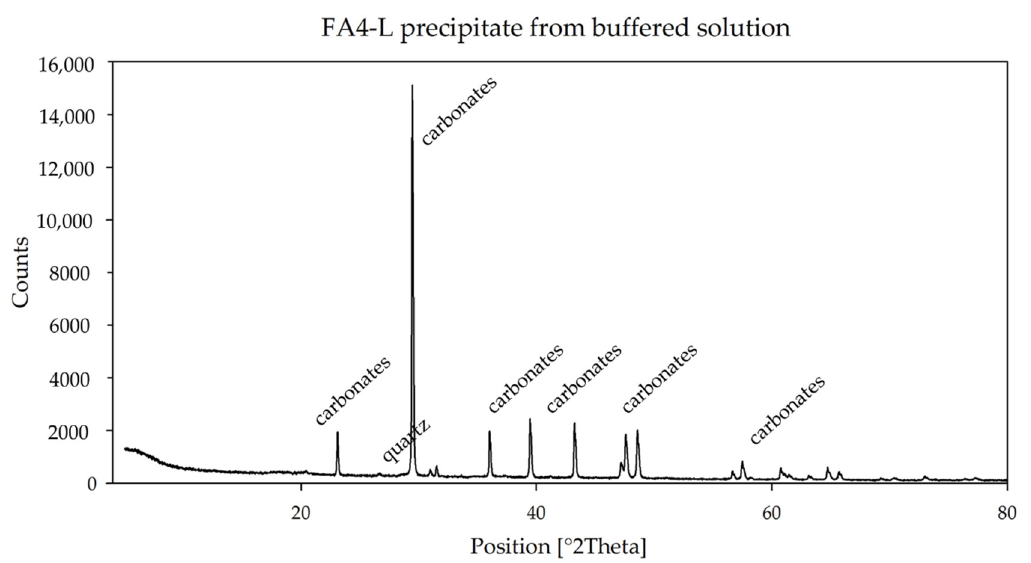
and EDS spectra with the detected chemical species, such as Al, Ca, Fe, Mg, and S (Figures